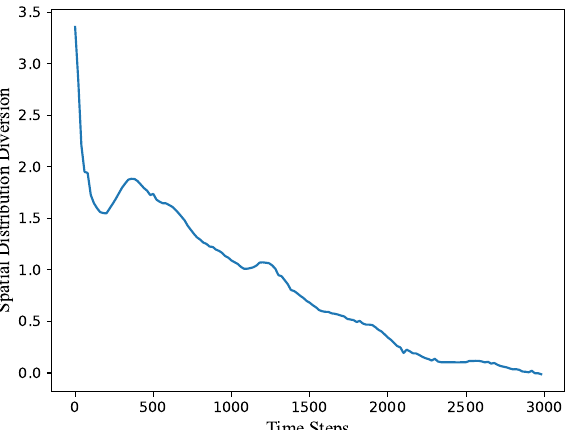
Figure 6. The variation of the spatial distribution diversion (SDD) value as a function of the calcula- tion time